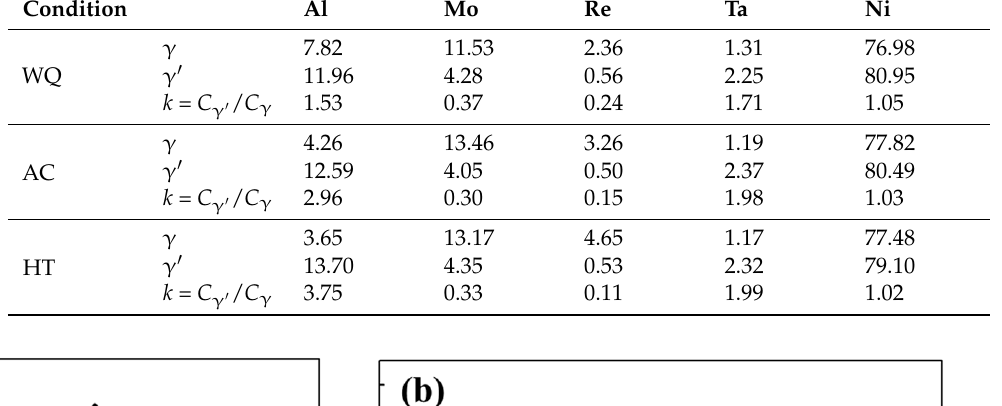
Table 4. The compositions of γ - and γ (cid:48) phase under different cooling conditions and fully heat treatment (at.%).